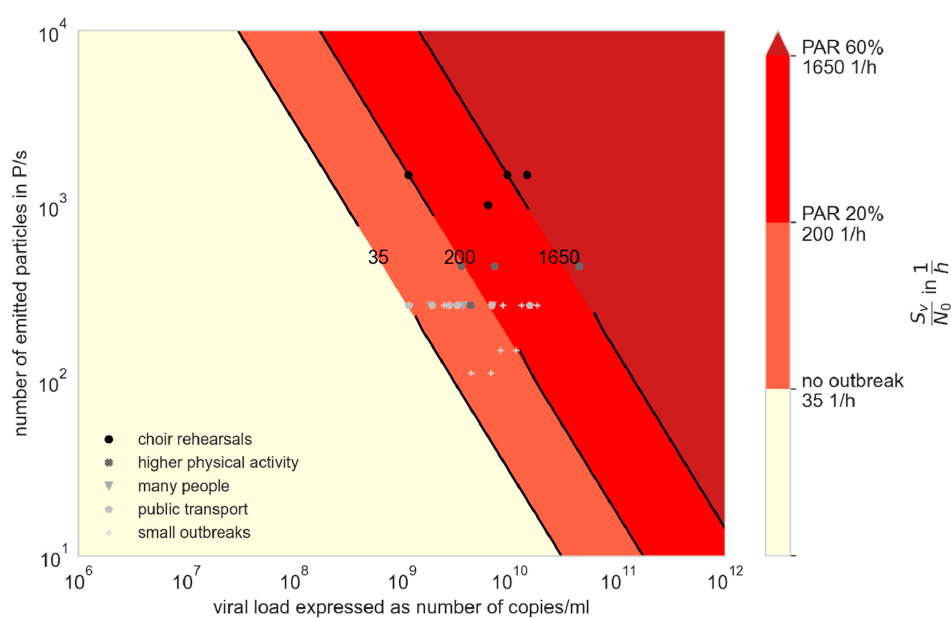
Figure 3. Virus factor (VF) for different viral loads and particle emission rates with N 0 = 100 viral copies. The attack rates found in the investigated outbreaks are shown with the different colors; the markers show the amount of virus factor at assumed mean particle emission rate of the related activity according to Figure 2.